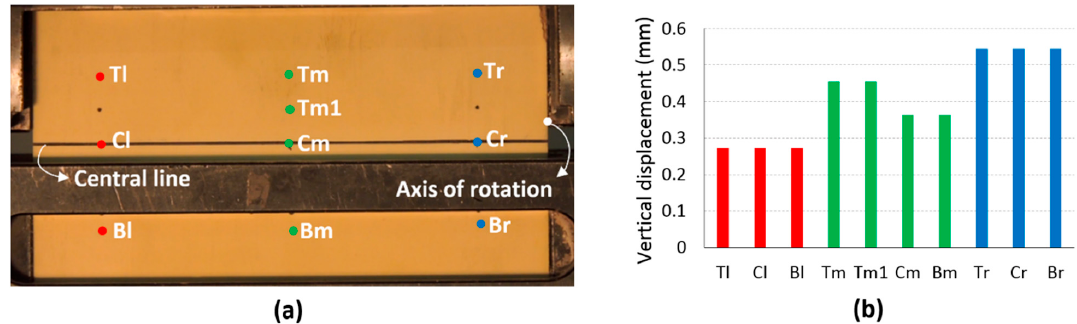
Figure 15. ( a ) The location of the points selected for DIC analysis, ( b ) Upward displacement of the points.